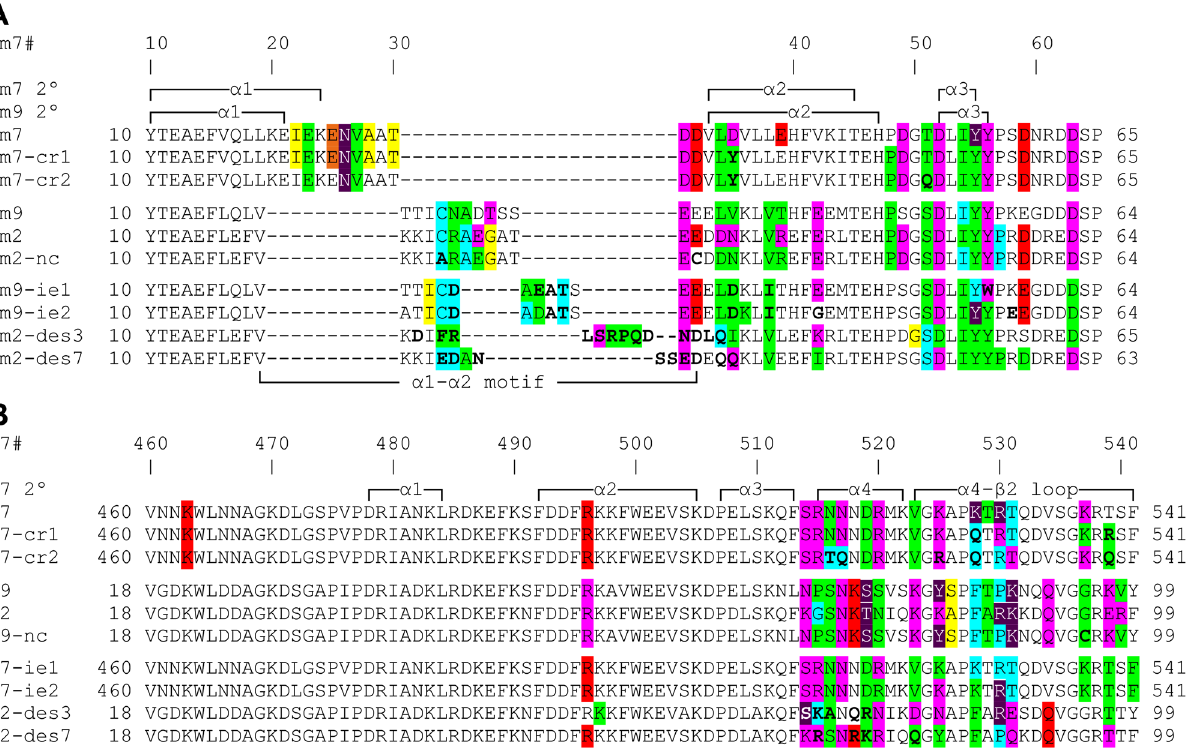
Figure 9. Residues in engineered colicin–immunity protein compexes that are predicted to contribute to inter-molecular interactions in the Im7-like family and E7-like family. ( A , B ) Residue-level sequence maps summarizing our structure-based energy calculations for the complexes of engineered immunity proteins ( A ) with their engineered colicins/pyocins ( B ). Residues that contributed substantially to interactions are colored as in Fig. 3. Mutations that were introduced are marked in bold. Immunity protein and colicin/pyocin positions are numbered according to Im7 (Im7#) and Col-E7 (E7#) and, together with the Im7/E7 secondary structure elements, are shown above and below the